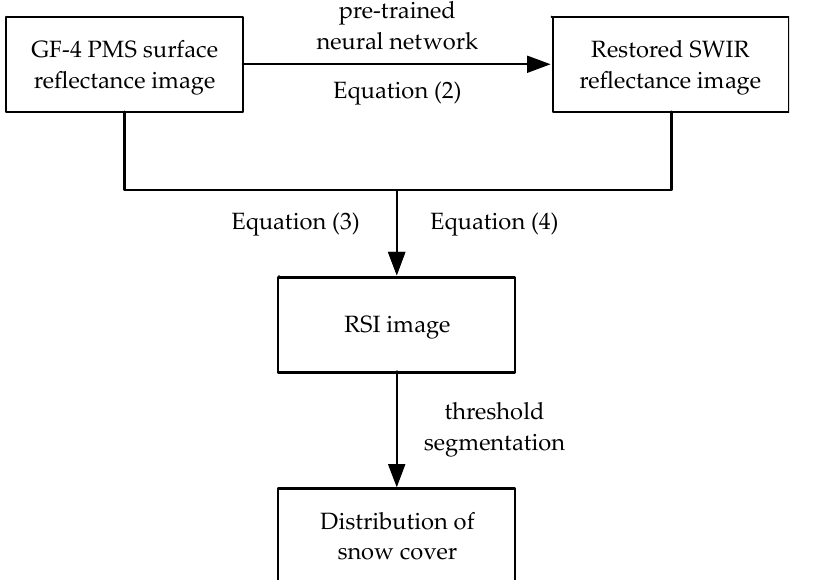
Figure 11. Flowchart of the RSI method for snow cover monitoring form GF-4 PMS imagery.